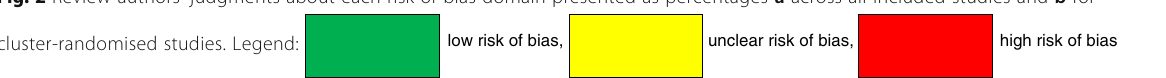
Fig. 2 Review authors ’ judgments about each risk of bias domain presented as percentages a across all included studies and b for cluster-randomised studies. Legend: low risk of bias, unclear risk of bias, high risk of